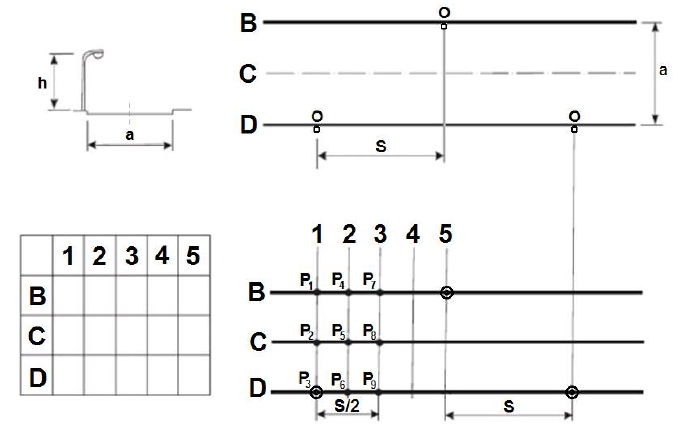
Figure 3. Determination of the mean illuminance and uniformities by a matrix of nine points (3 × 3).